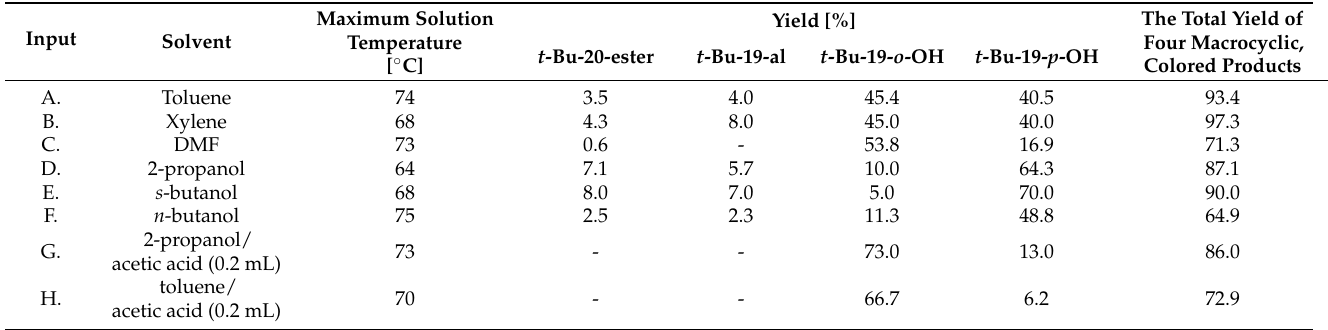
Table 1. Yields of the four, colored, macrocyclic products obtained in photochemical rearrangements of t -Bu-19-Azo-O *.